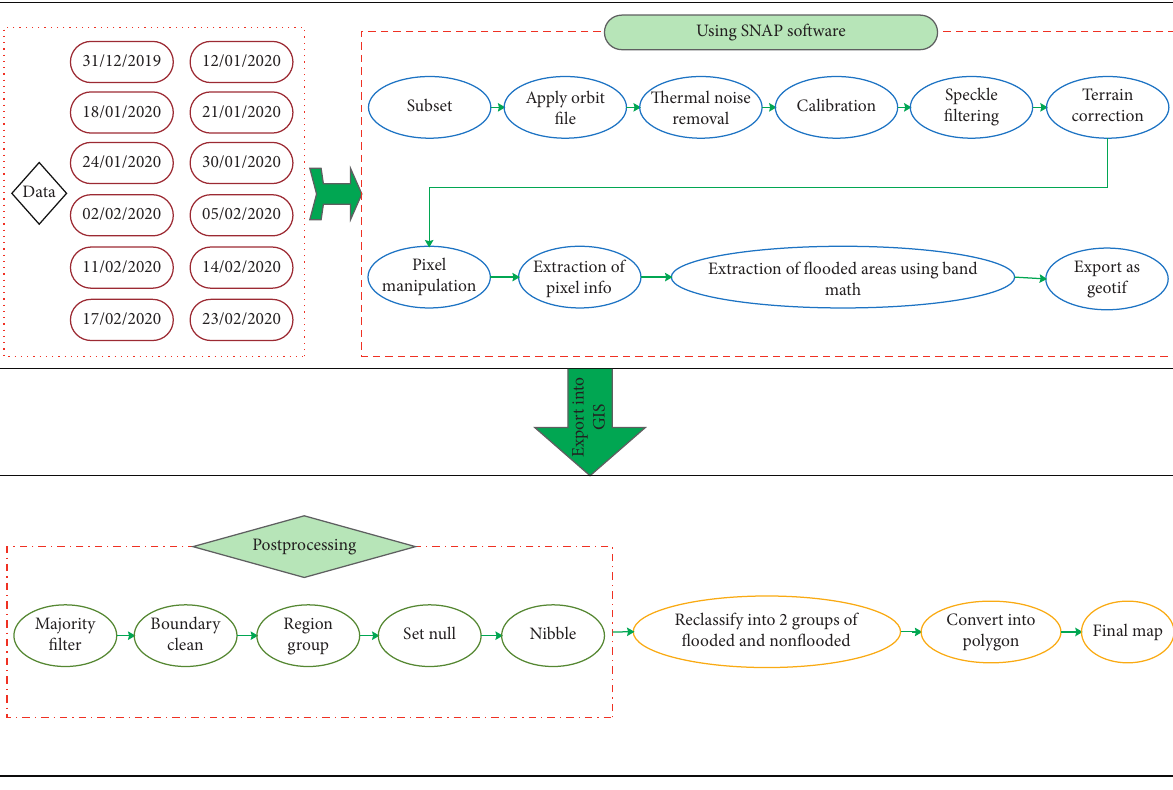
Figure 8: Methodology of time series